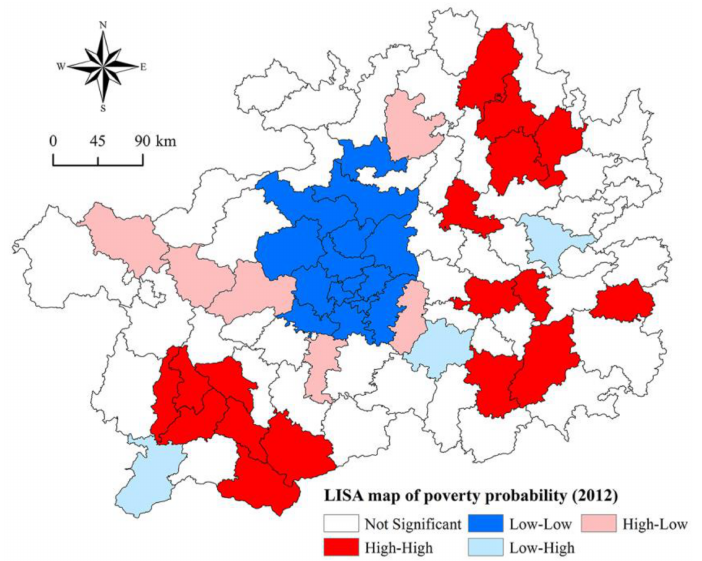
Figure 10. Local Indicators of Spatial Association (LISA) map of poverty probability at the county level for